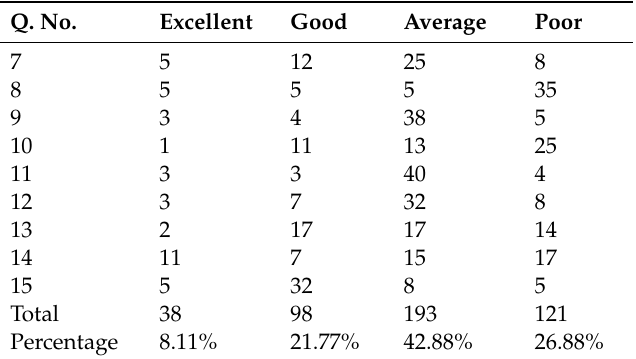
Table 6. Group II based on Questions